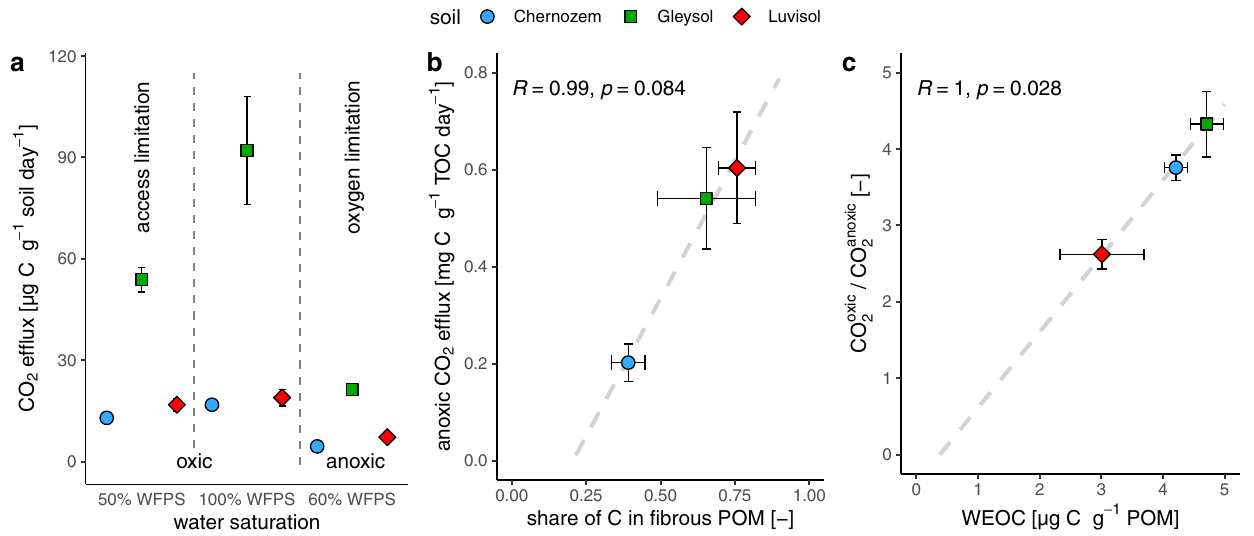
Fig. 7 Soil respiration results from short-term incubations. a Absolute CO 2 ef fl ux rates under oxic (20% O 2 ) and anoxic (0% O 2 ) conditions at different moisture levels (WFPS, water- fi lled pore space). b Relative CO 2 ef fl ux rates, i.e. as a fraction of total organic C, scale linearly with the share of image- derived C in fi brous particulate organic matter (POM) to that in total POM. c The increase in CO 2 ef fl ux rates through the presence of oxygen (at 100% WFPS) scales linearly with the water-extractable organic C (WEOC) leached from POM. Bars represent two standard errors in each direction with n = 3 for CO 2 and WEOC data and n = 8 for image-derived POM